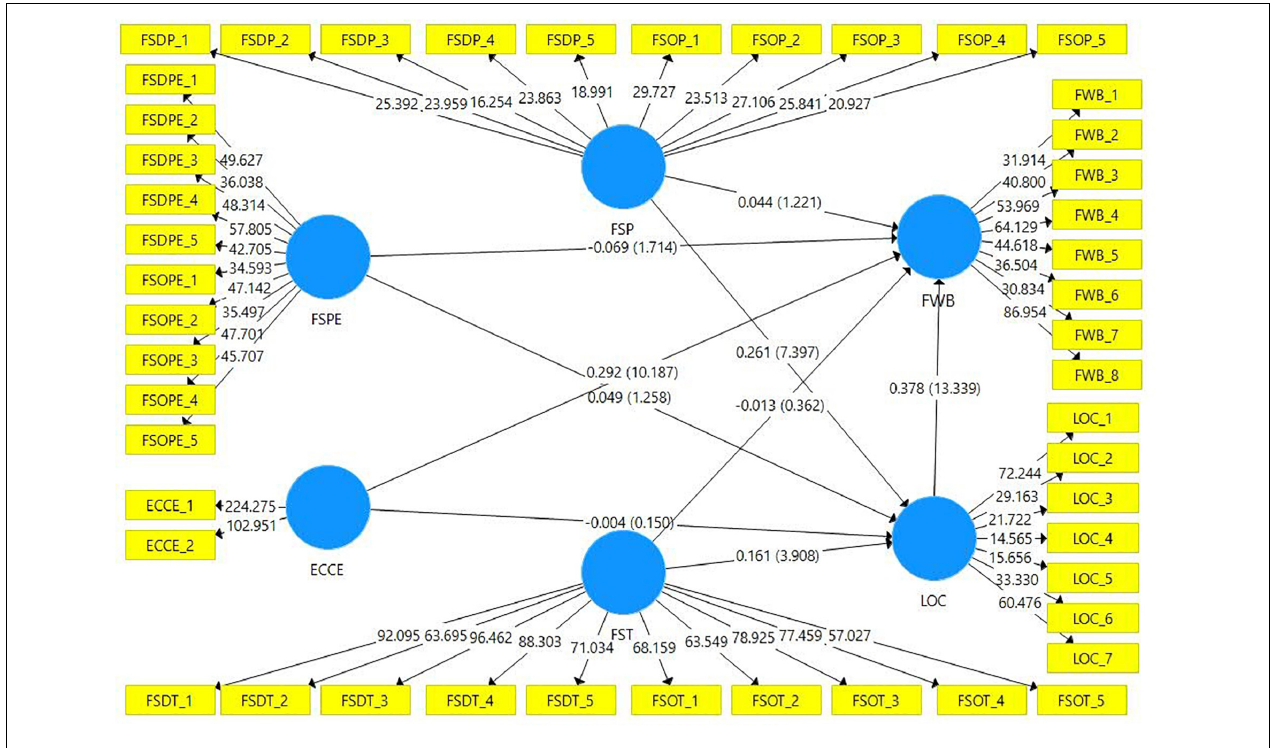
FIGURE 2 | Regression coefficients.